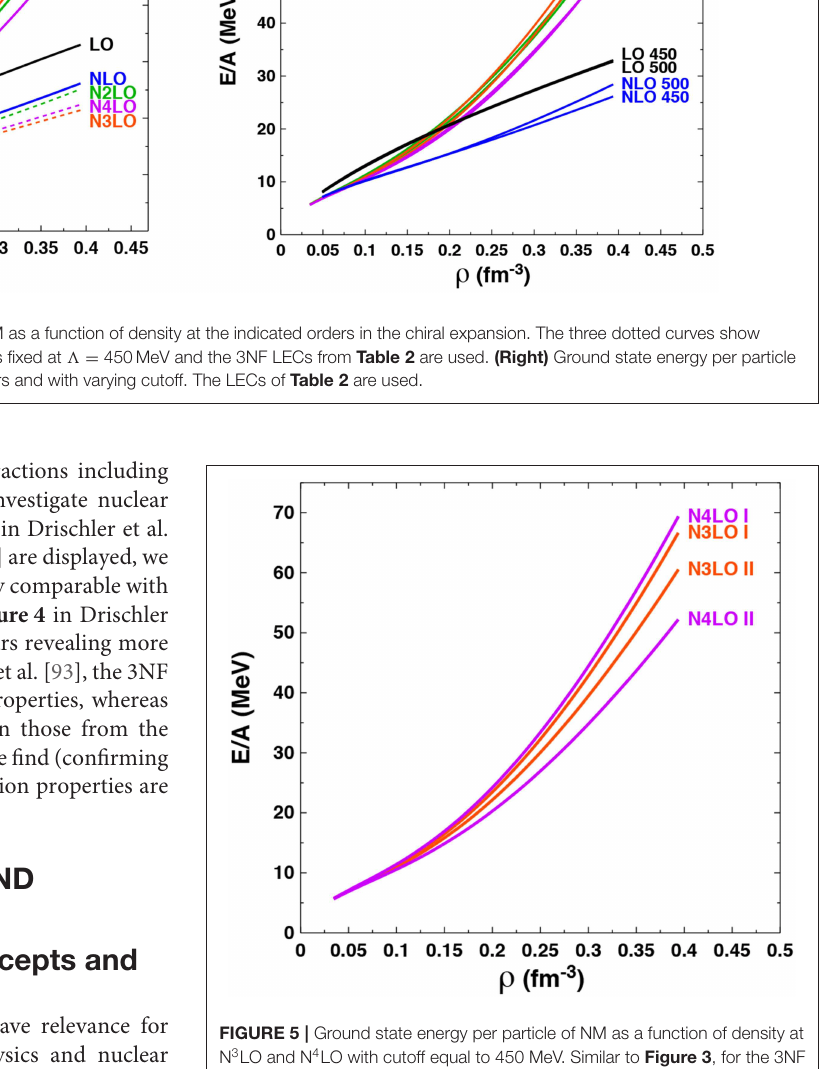
FIGURE 5 | Ground state energy per particle of NM as a function of density at N 3 LO and N 4 LO with cutoff equal to 450 MeV. Similar to Figure 3 , for the 3NF contributions the LECs of either Table 1 or Table 2 are applied as indicated by labels “I” or “II,”